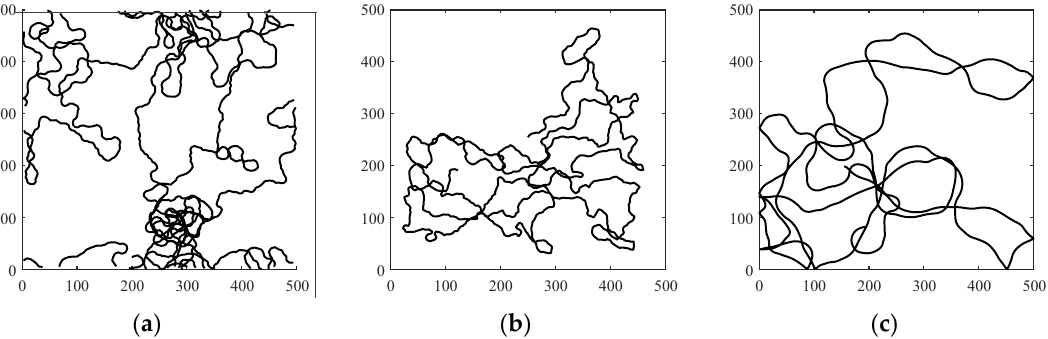
Figure 6. Column mobility models: ( a ) Example of a single step in CLMN where each node has its reference point and reference points are placed on a reference line that moves a distance d and rotates an angle θ ; ( b ) Trajectory simulation of three nodes using CLMN where reference points randomly move through the simulation area and each node moves randomly around its reference point.